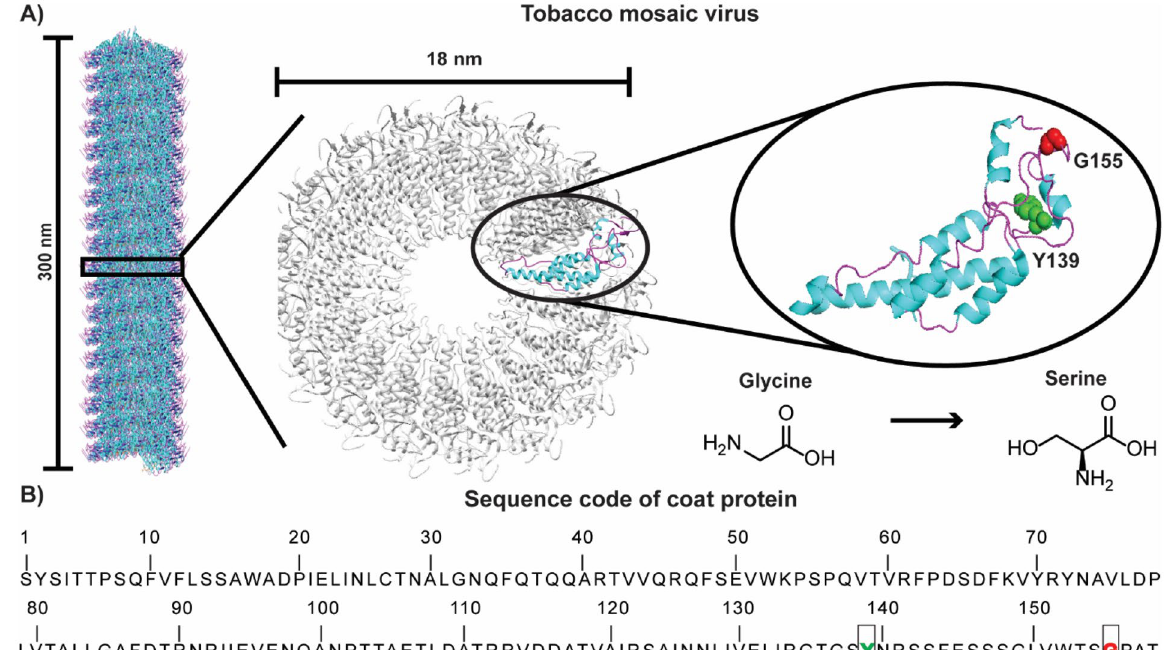
Figure 3. (A) TMV particle showing 300 nm in length and cross-section with an 18 nm diameter. A single coat protein is highlighted showing helices in cyan and loops in magenta. Gylcine 155 (red) and tyrosine 139 (green) are shown as spheres. Figure was prepared using PDB 3J06 in Chimera 1.15 (https:// www. cgl. ucsf. edu/ chime ra/ downl oad. html) and PyMOL 2.5.1 (https:// pymol. org/2/). (B) Coat protein sequence (https:// www. rcsb. org/ fasta/ entry/ 3J06/ displ